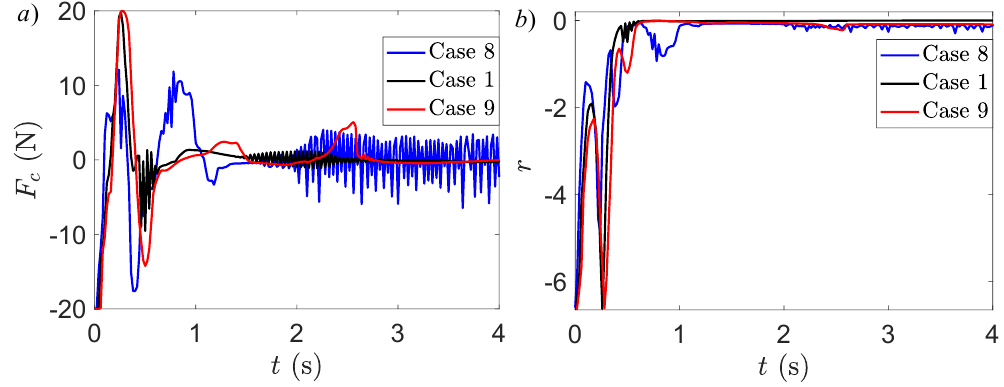
Figure 10. Controller force and agent reward for the task of Cases 1, 8, and 9. ( a ) Controller force during the swing-up task. ( b ) Agent reward during the swing-up task.